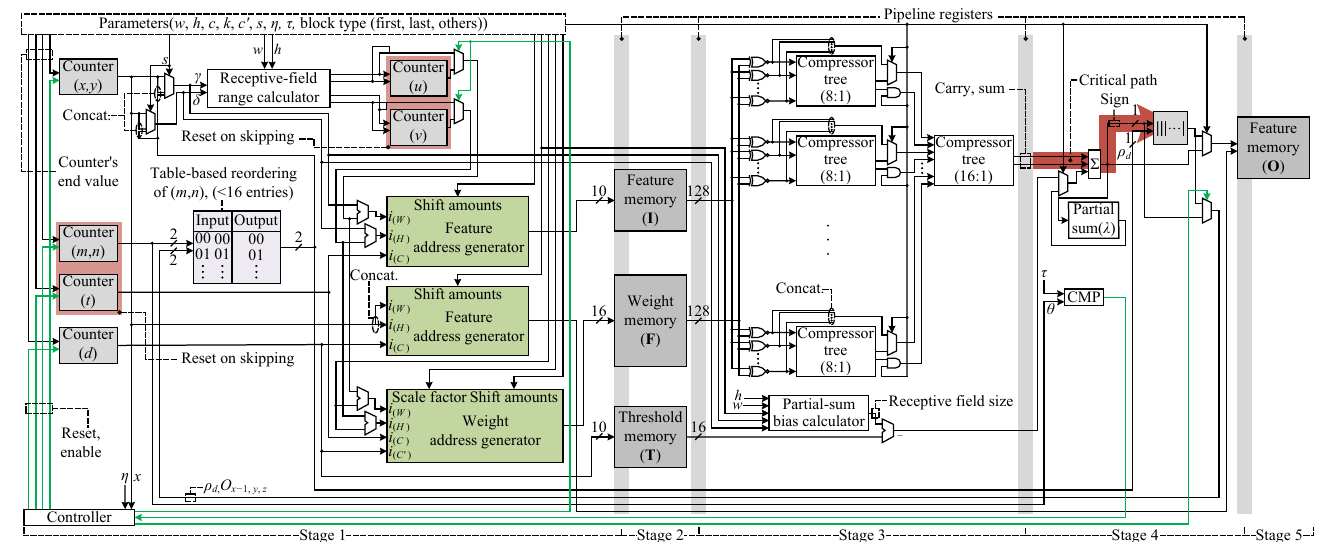
Figure 5. Processing pipeline for Algorithm 1, where CMP stands for a comparator and the variables correspond to those in Algorithm 1. The control signals have been colored